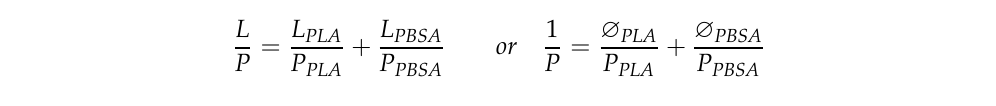
Table 7. Water permeation parameters for the PLA/PBSA, PLA/PBSA2 and PLA/PBSA5 multilayer films. Experimental and predicted values.